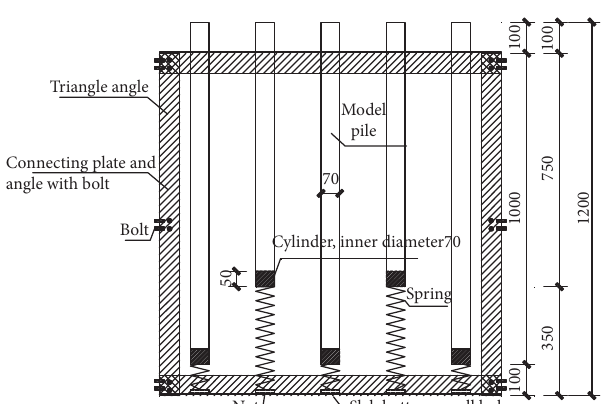
Figure 2: Vertical view of the test model.